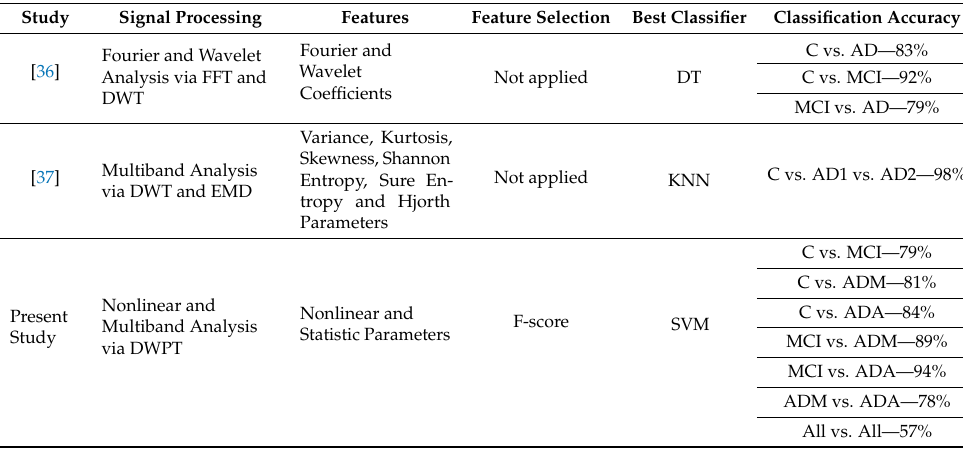
Table 6. Comparison with previous works with different EEG